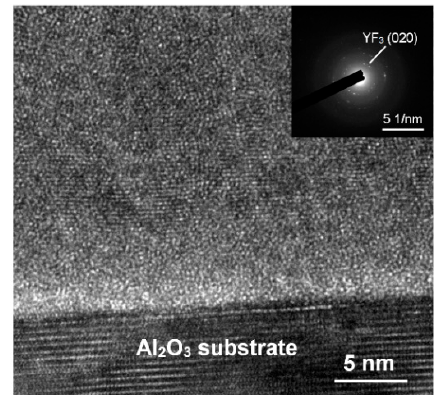
Figure 1. XRD patterns of the as-deposited yttrium fluoride (YF 3 ) films grown at 400, 500, 600, and 700 °C.